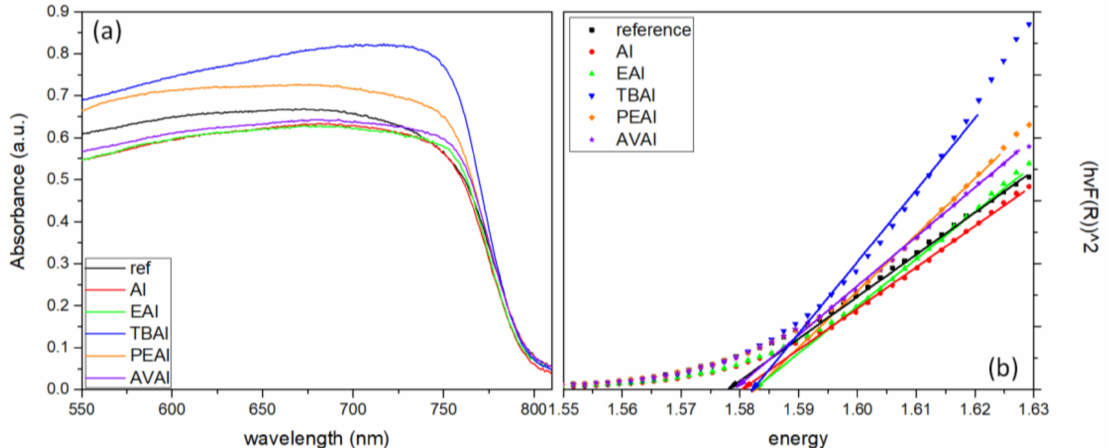
Figure 10. ( a ) UV-vis absorption spectra and ( b ) Tauc plots of the 6 perovskite films under